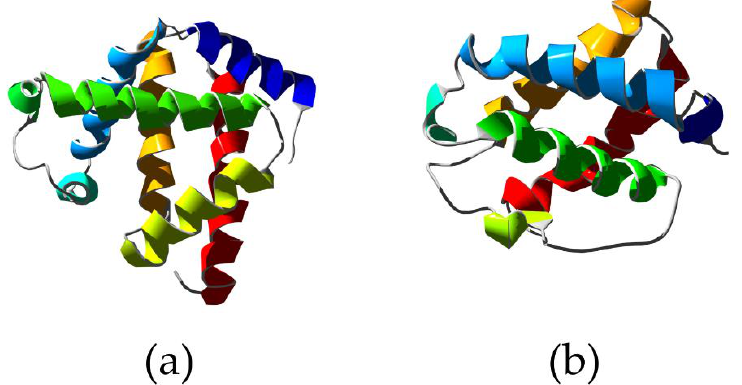
Figure 2. X-ray structure of Physeter catodon myoglobin showing the typical 3/3 alpha helical sand- wich ( a ) (PDB ID 1A6K [63]) compared to the structure of truncated hemoglobin from Chlamydomonas eugametos showing the 2/2 alpha helical sandwich ( b ) (PDB ID 1DLY [64]). Ribbons are colored following secondary structure succession.